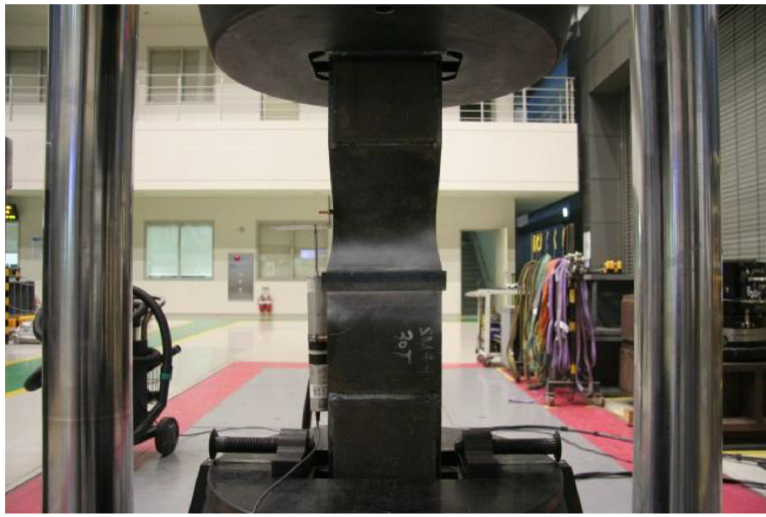
Figure 5. Specimens for direct tensile test at welding joint.